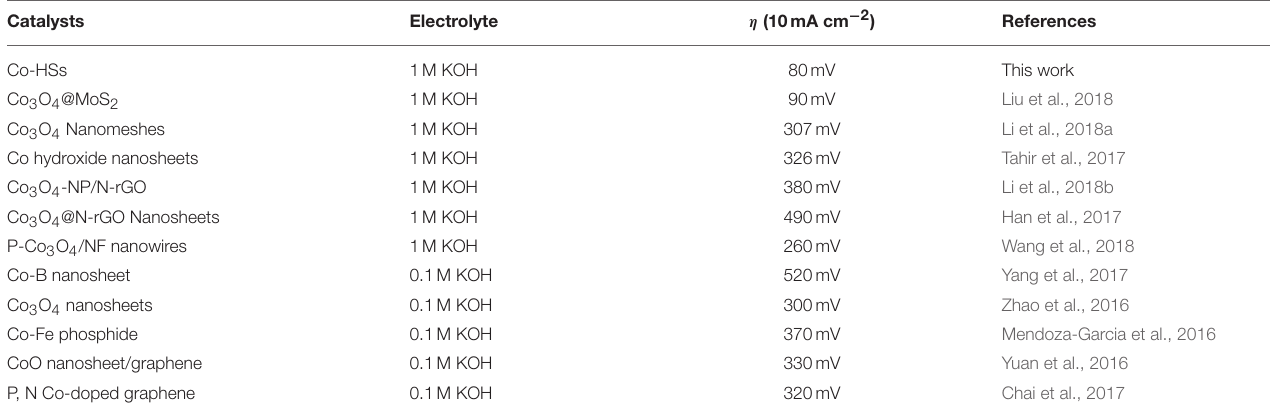
TABLE 1 | Comparison of the as-prepared Co-HSs electrochemical performance with literature reported the Co-based electrocatalysts. Catalysts